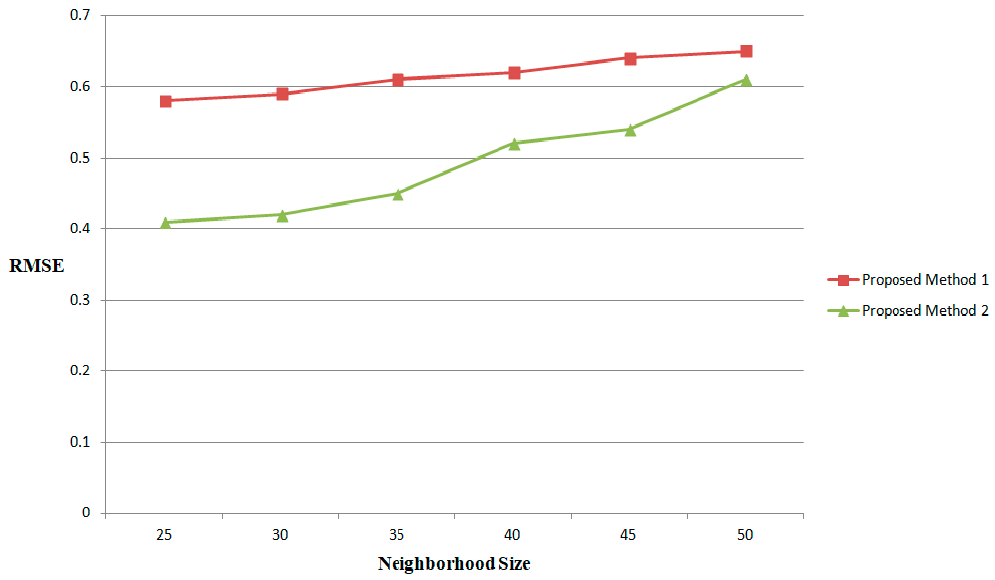
Figure 7. The RMSE Comparison of the Proposed Methods for Different Neighborhood Sizes.